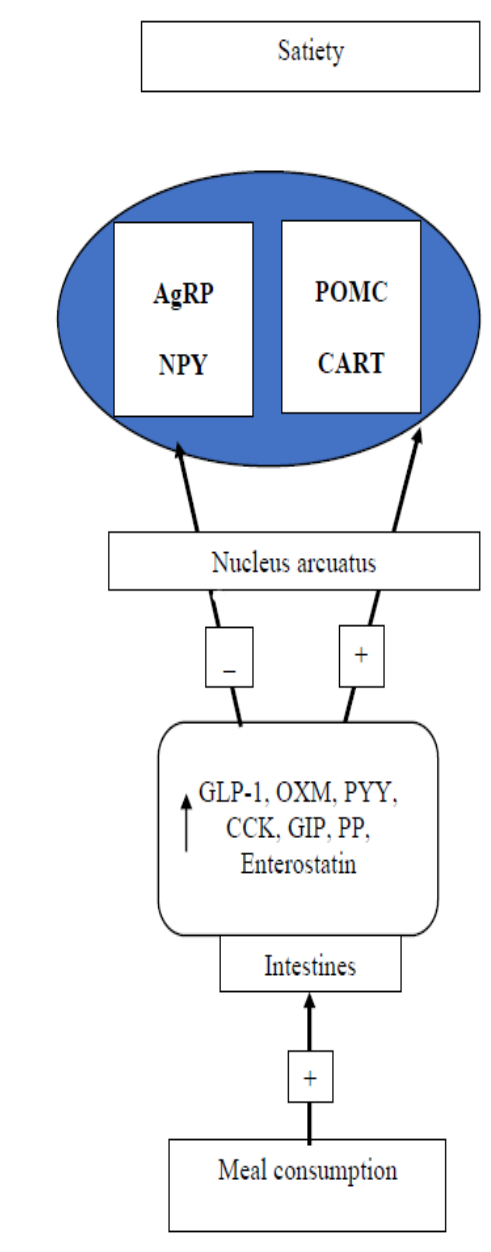
Figure 3. The brain–gut axis in the regulation of feeling hunger and satiety. AgRP: Figure 3. The brain-gut axis engaged in the regulation of feeling hunger and satiety. AgRP: agouti-related peptide; NPY: neuropeptide Y; POMC: pro-opiomelanocortin; CART: cocaine- and amphetamine-regulated transcript; GLP-1: glucagon-like peptide 1; OXM: oxyntomodulin; PYY: peptide tyrosine tyrosine; CCK: cholecystokinin; GIP: glucose- dependent insulinotropic polypeptide; PP: pancreatic polypeptide.